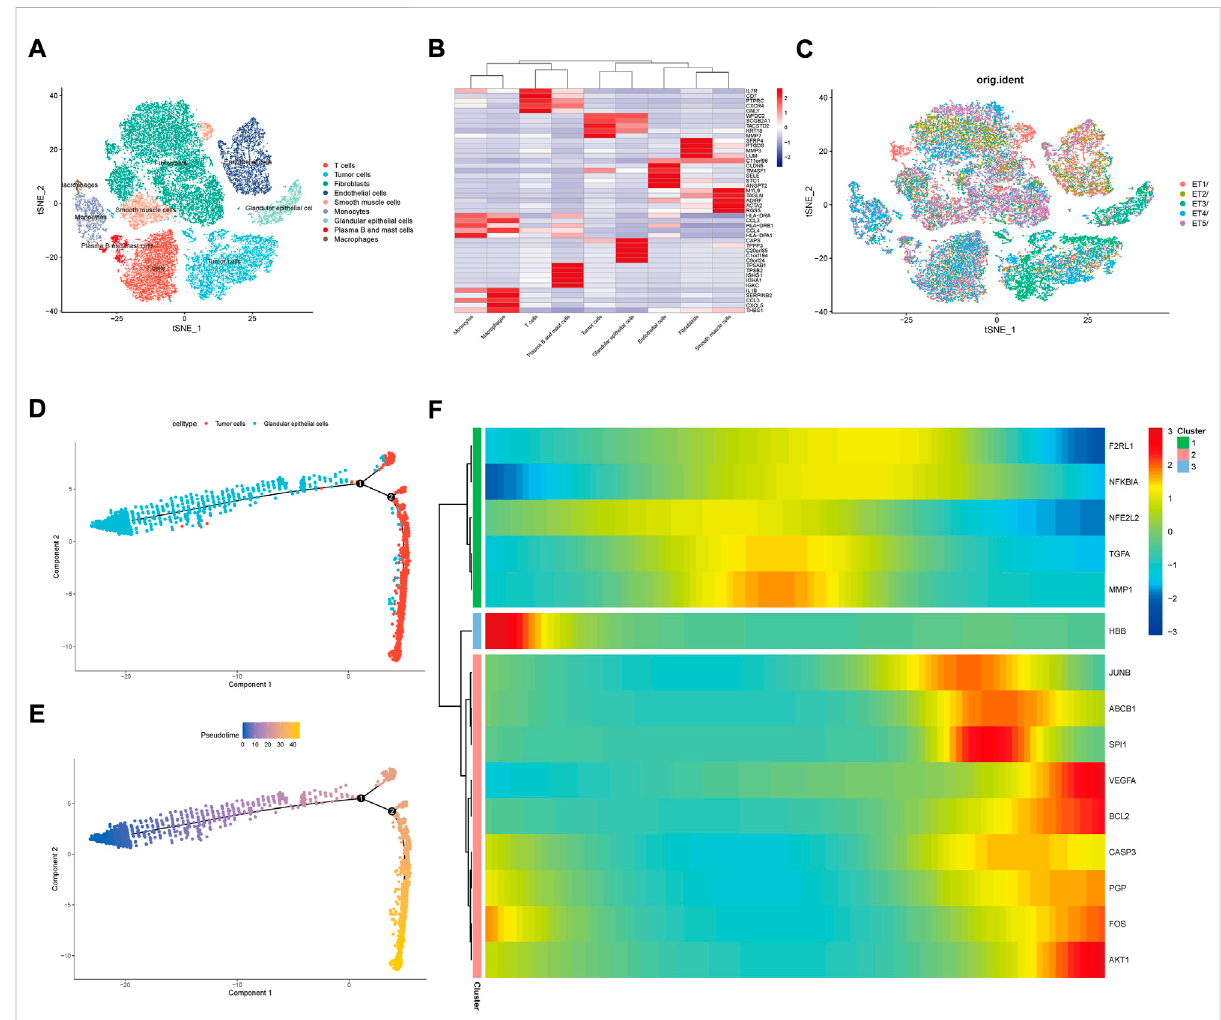
FIGURE 7 Single-cellsequencing subgroups and cell trajectory analysis. (A) Nine major cell subgroups of UCEC tumor tissues wereconstructed byt-SNE analysis; (B) Visualization of Marker gene expression in the 9 cell subgroups; (C) Distribution of single-cell sequencing data from fi ve UCEC patient samples in t-SNE analysis; (D,E) Glandular epithelial cells versus Tumor cells in cell trajectory analysis graphs; (F) Expression changes of DR-DEGs with cell